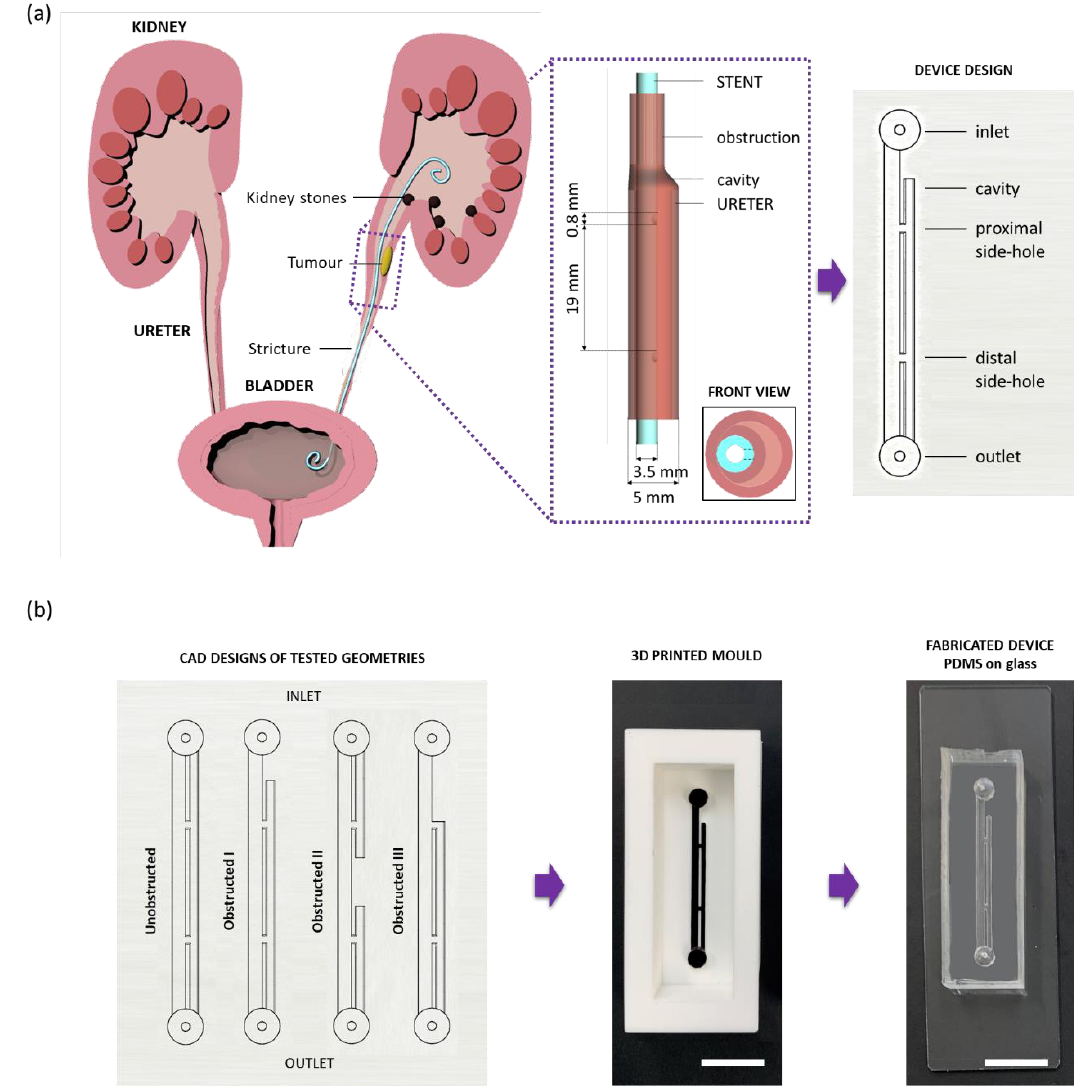
Figure 1. Illustration of the design rationale and manufacturing steps for the stent-on-a-chip (SoC) devices. Ureteral stents are clinically deployed to promote drainage of urine from kidneys to